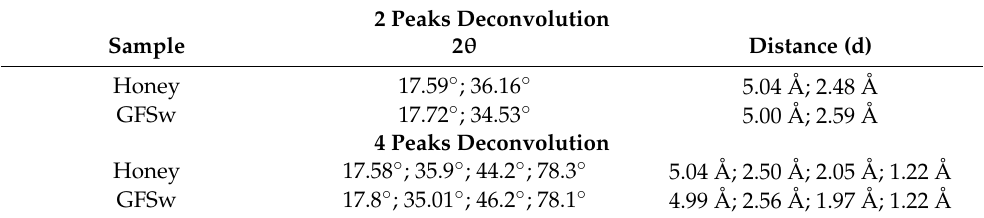
Table 5. XRD parameters from the Gaussian deconvolution of diffractograms for honey and GFSw. 2 Peaks C D